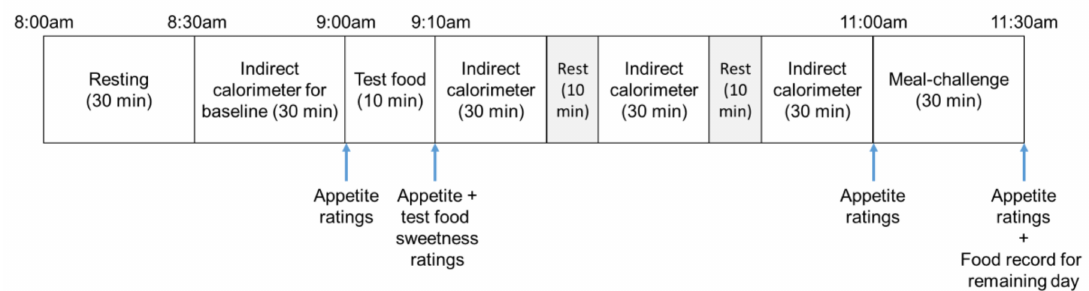
Figure 1. Experimental protocol on test day outlining study activities and time points when measurements were taken during the